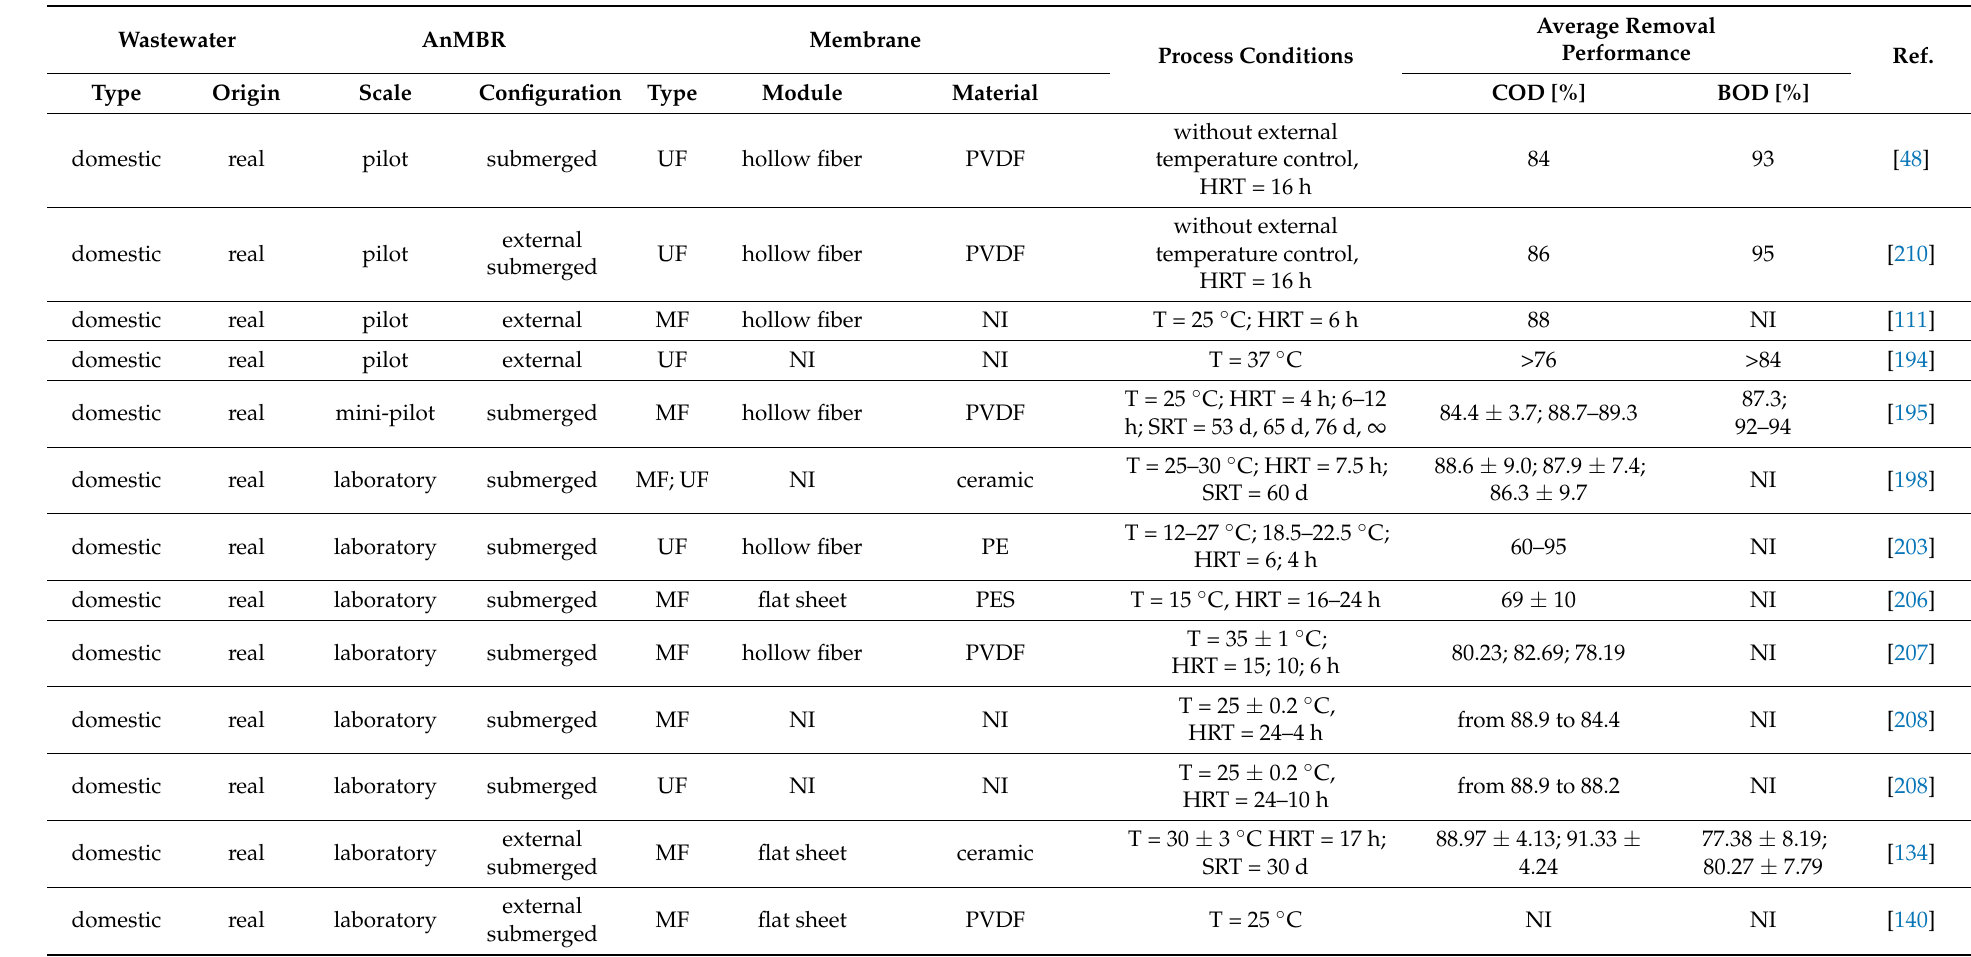
Table 6. A summary of the studies on the treatment of domestic wastewaters in